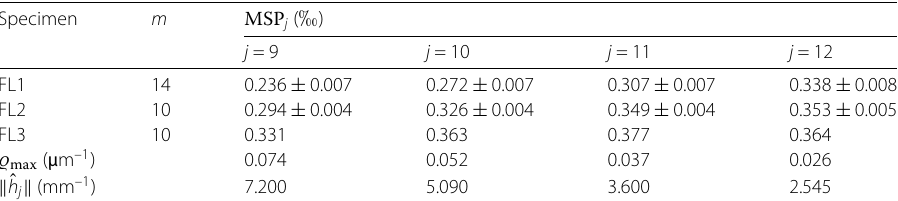
Table 2 Estimates of MSP j for j = 9, ... ,12. The error is the standard deviation of the mean of the estimates from the individual images. The position (cid:7) max of the maximum and the norm (cid:3)ˆ h j (cid:3) of the transfer function ˆ h j ( ξ ) are included to facilitate interpretation